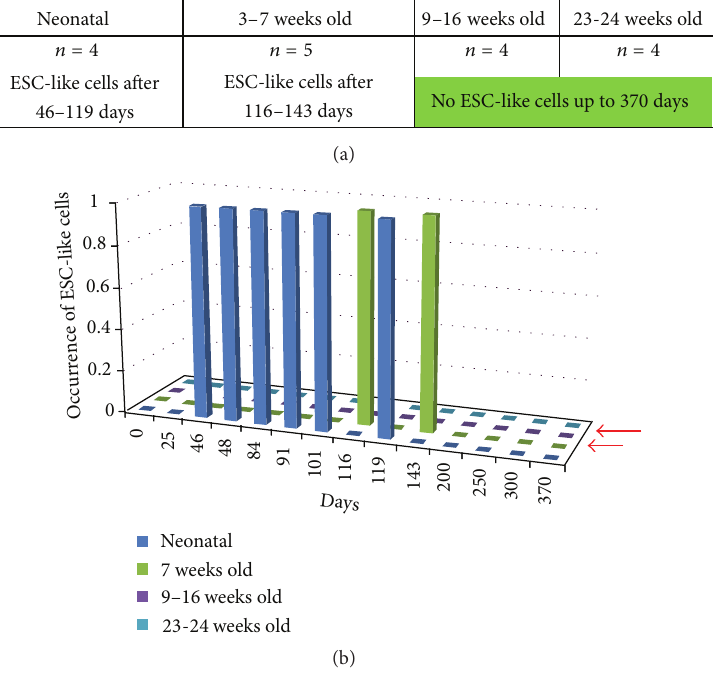
Figure 5: (a) Table and (b) graph demonstrate that ESC-like cells can only be obtained with SSCs obtained from mice until the age of 7 weeks. SSCs obtained from older adult animals are unable to show a shift to pluripotency (red